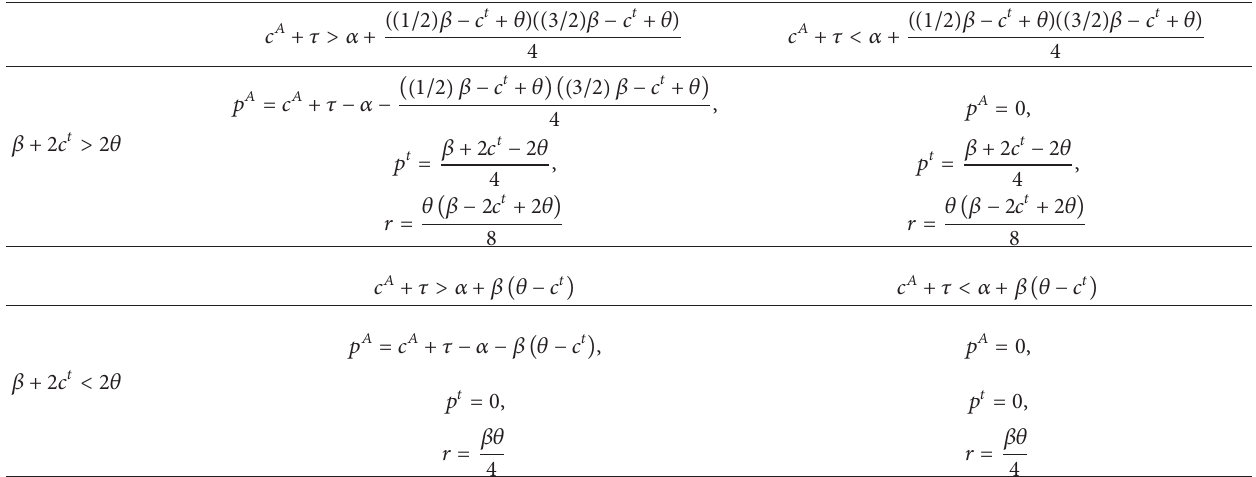
Table 2: The optimal price structure of duopolistic IM platforms when advertisers choose multi-homing.